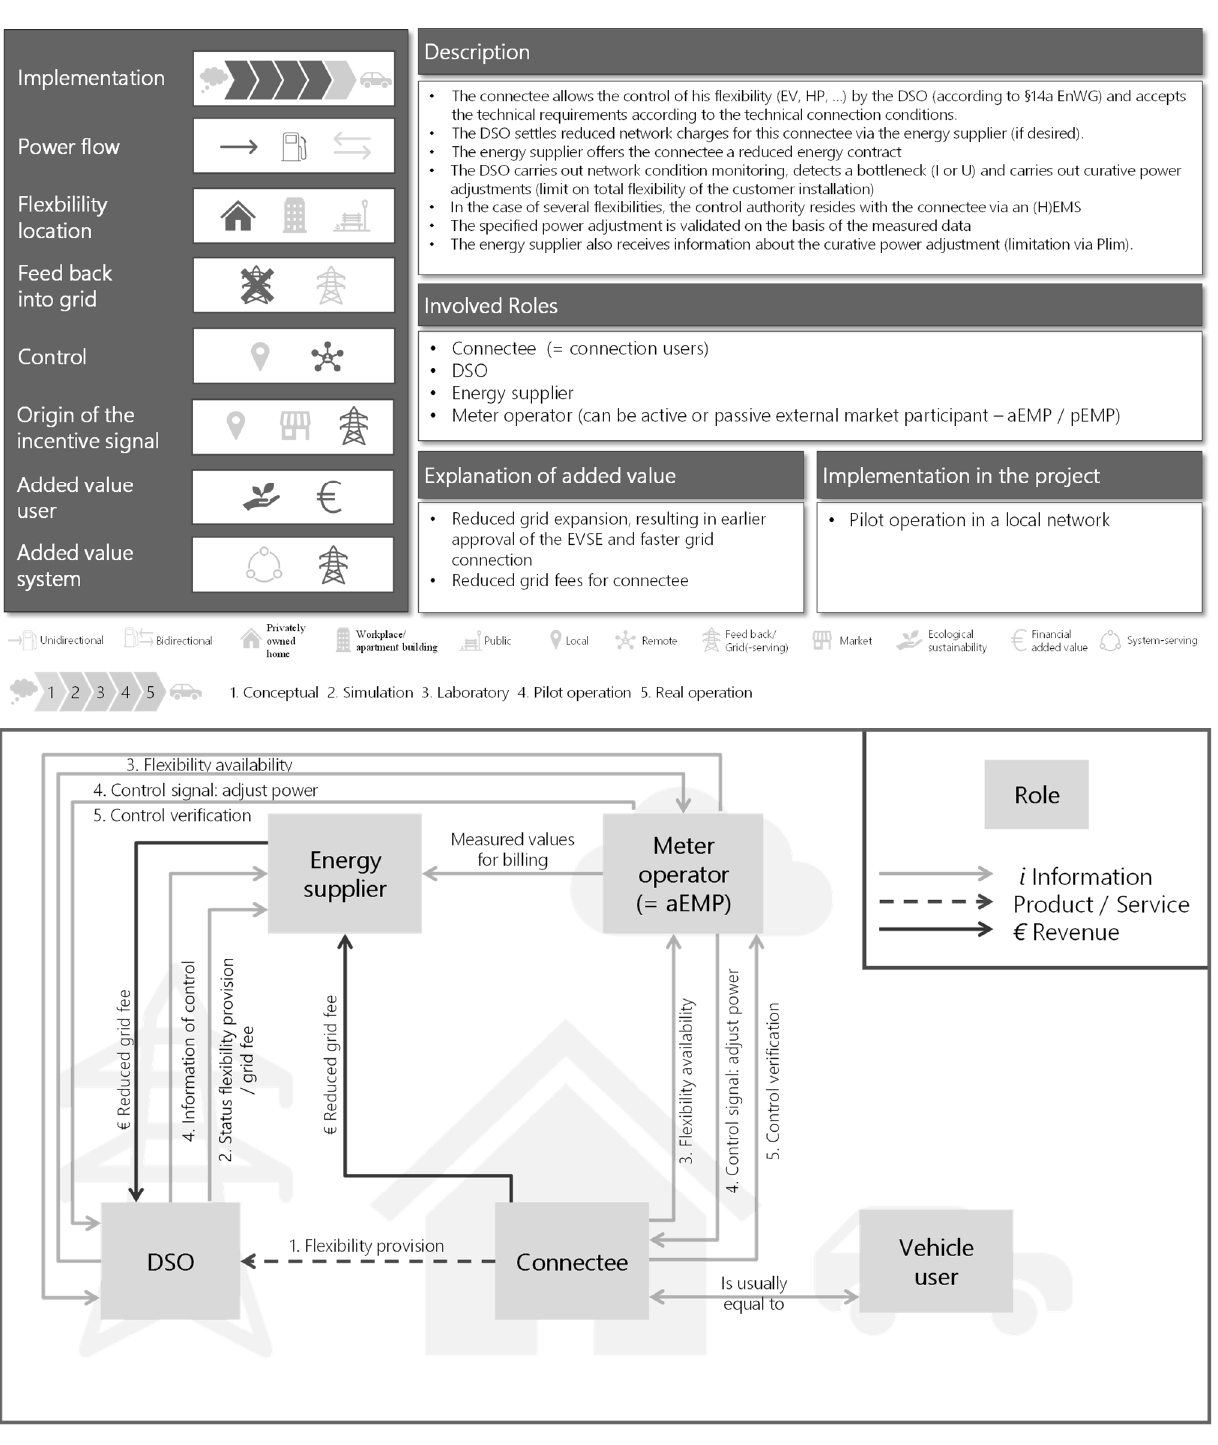
Figure 3. BUC regulatory-defined grid-serving unidirectional flexibility for privately owned home: description template ( top ) and e3-value model ( bottom ).